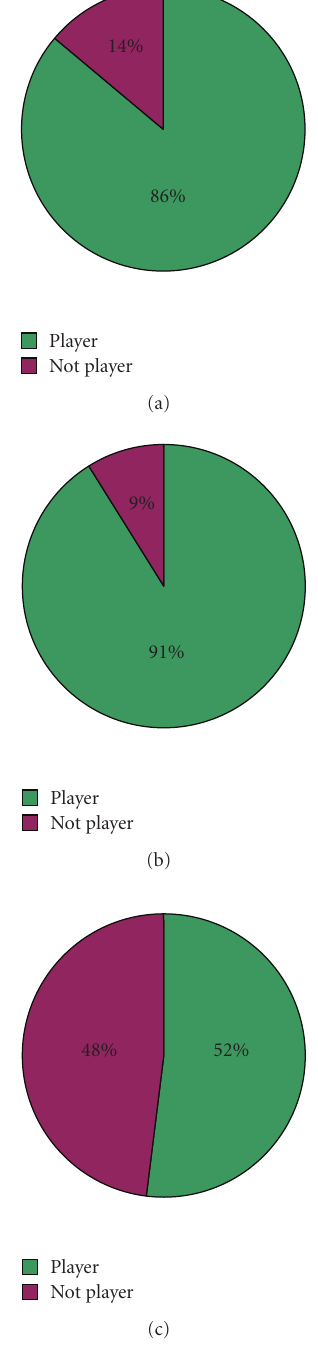
Figure 3: (a) Players’ percentage for all participants, (b) males, and (c)